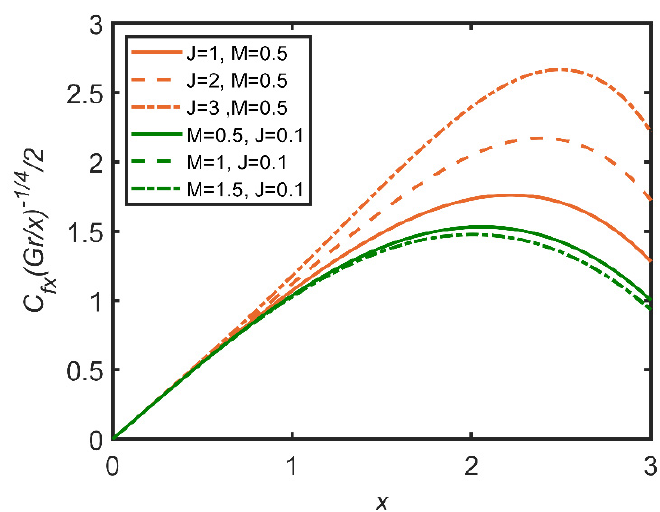
Figure 21. Comparison for skin friction against x.